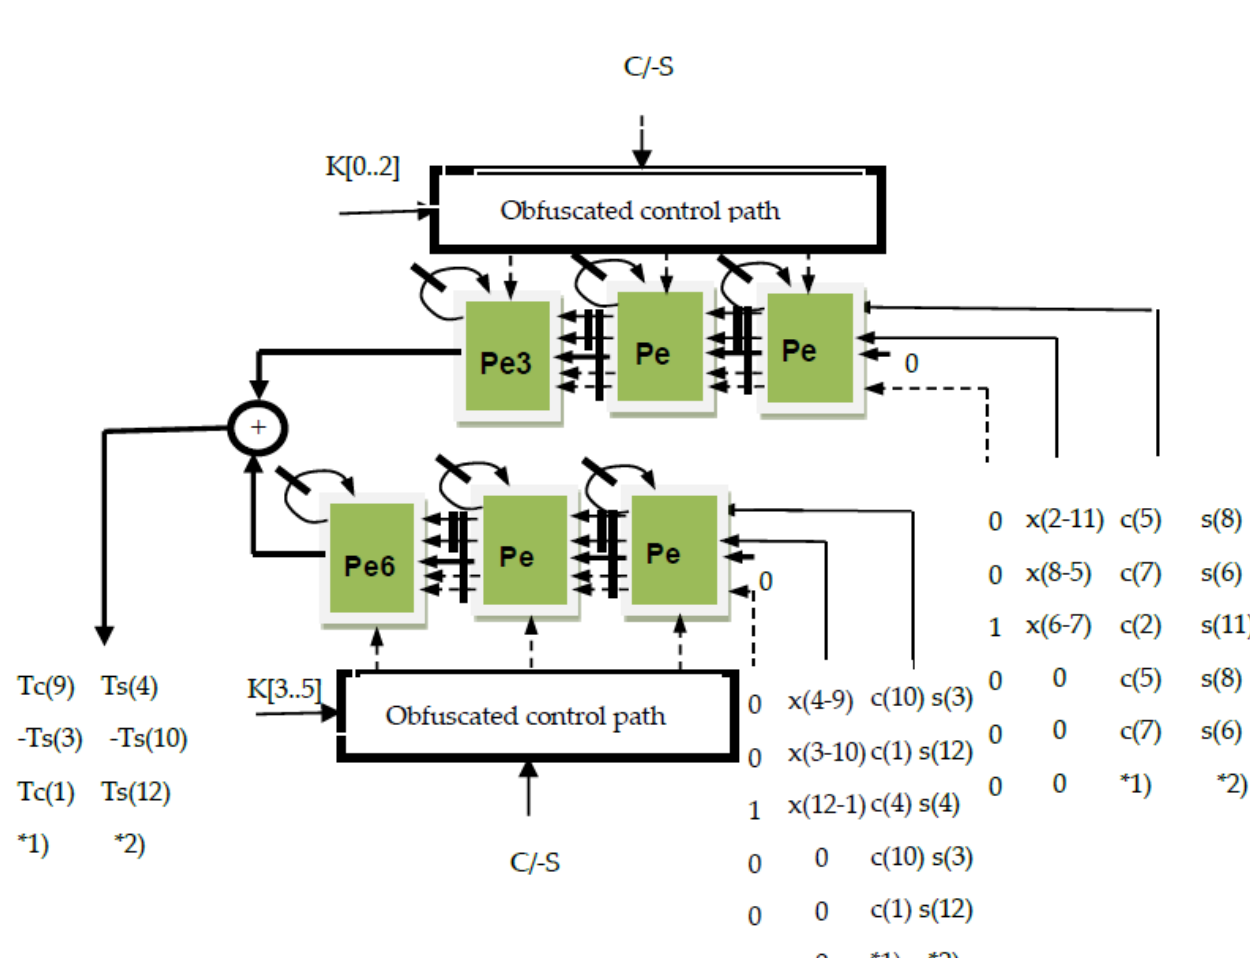
Figure 16. The unified VLSI architecture for DCT/DST-IV based on the unified algorithm for Equations (12) and (29) where *1) represents the cosine entry that is in parallel with *2) the sine entry; the correct entry is selected depending on the pre-processing stage to calculate what is needed (DCT-IV or DST-IV).